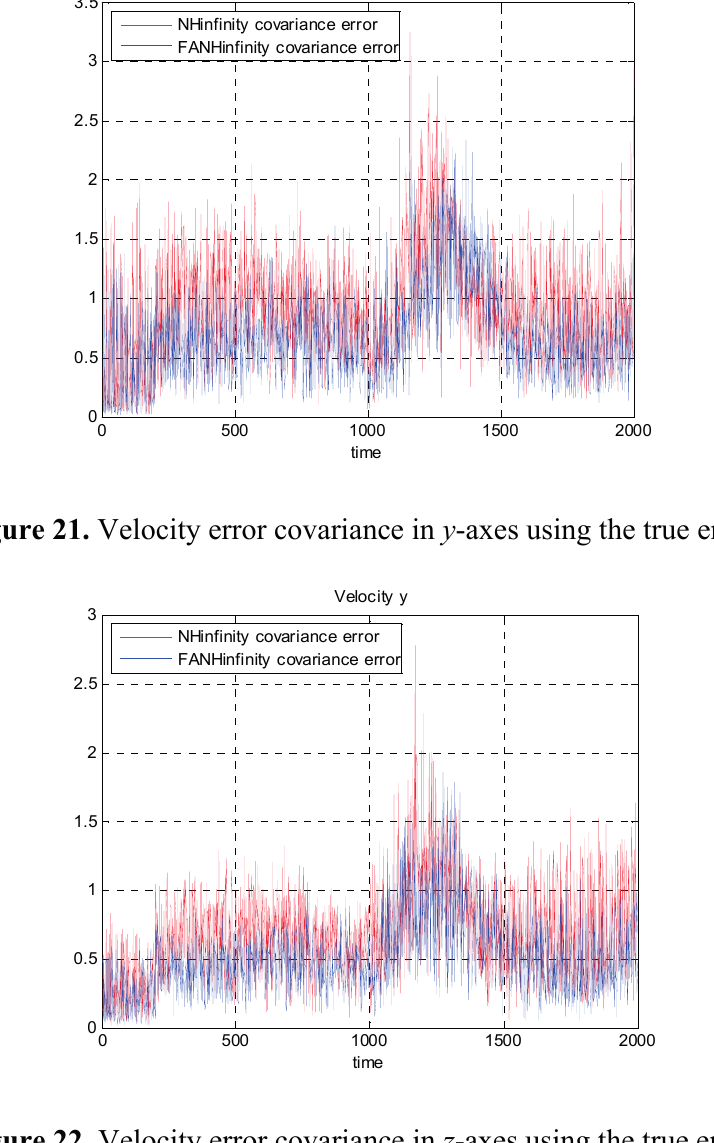
Figure 22. Velocity error covariance in z -axes using the true